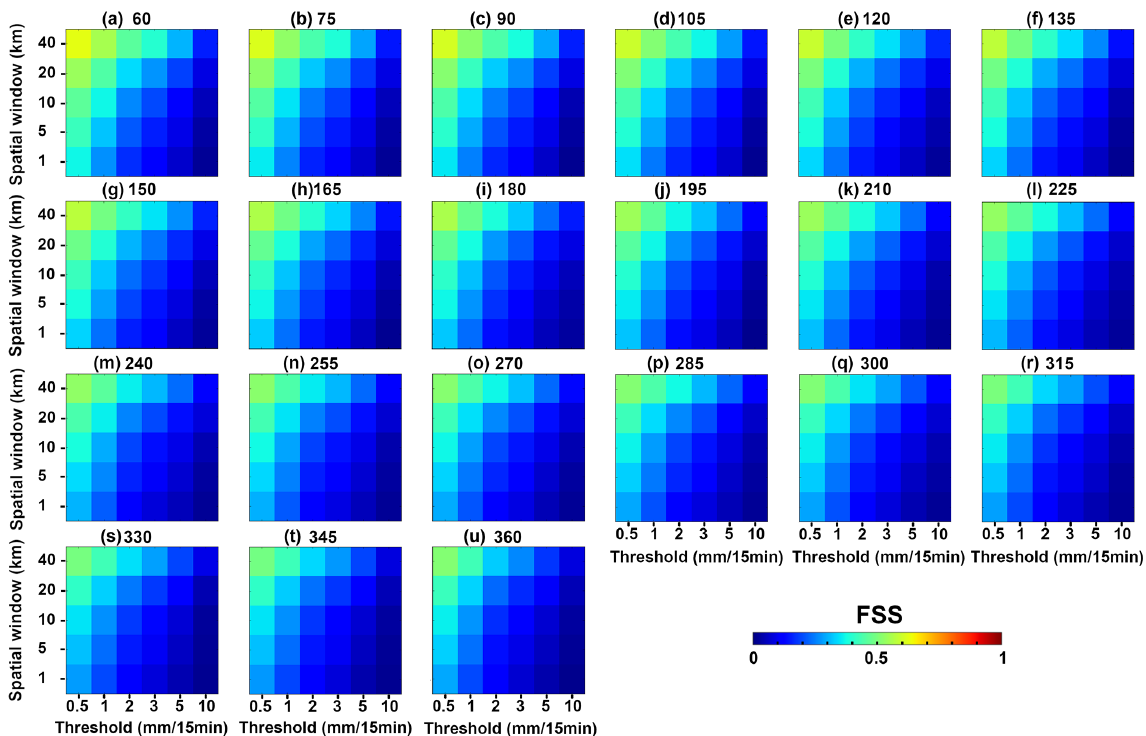
Figure 6. The 10-events mean FSS obtained with AROME-NWC for the different precipitation thresholds (0.5, 1, 2, 3, 5 and 10mm/15min) and window sizes (1, 5, 10, 20 and 40km) at each forecast lead time from (a) 60min to (u) 360min.